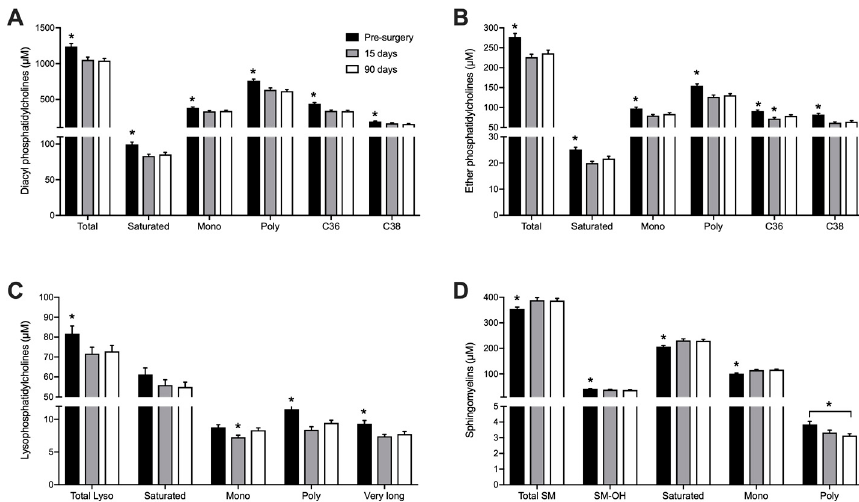
Figure 3. Whole blood concentration of Phosphatidylcholines (diacyl) ( A ), Ether-Phosphatidylcholines ( B ), Lysophosphatidylcholines ( C ) and Sphingomyelins ( D ) before, 15 and 90 days after RYGB. n = 26. * p < 0.05 when compared to all other groups, unless otherwise stated. Saturated: Sum of all molecules containing only saturated FA; mono: Sum of all molecules containing one monounsaturated FA; poly: Sum of all molecules containing at least one polyunsaturated FA;